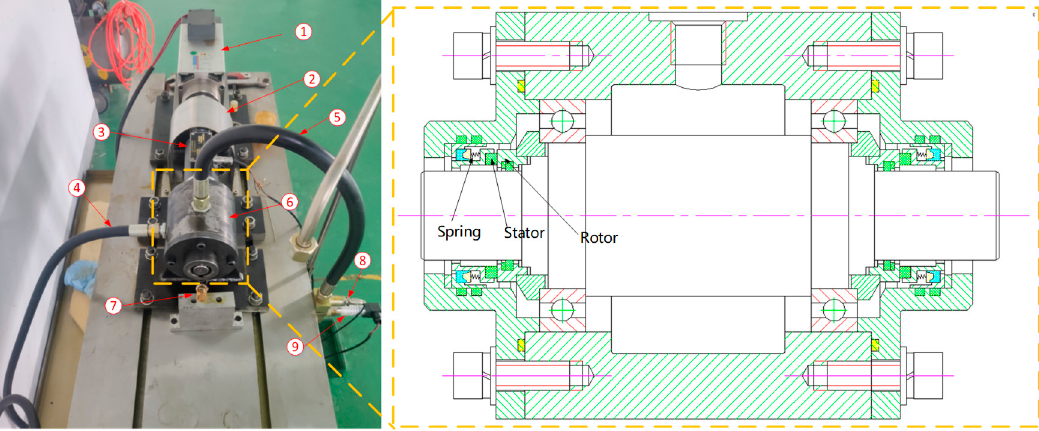
Figure 11. Mechanical seal test rig.